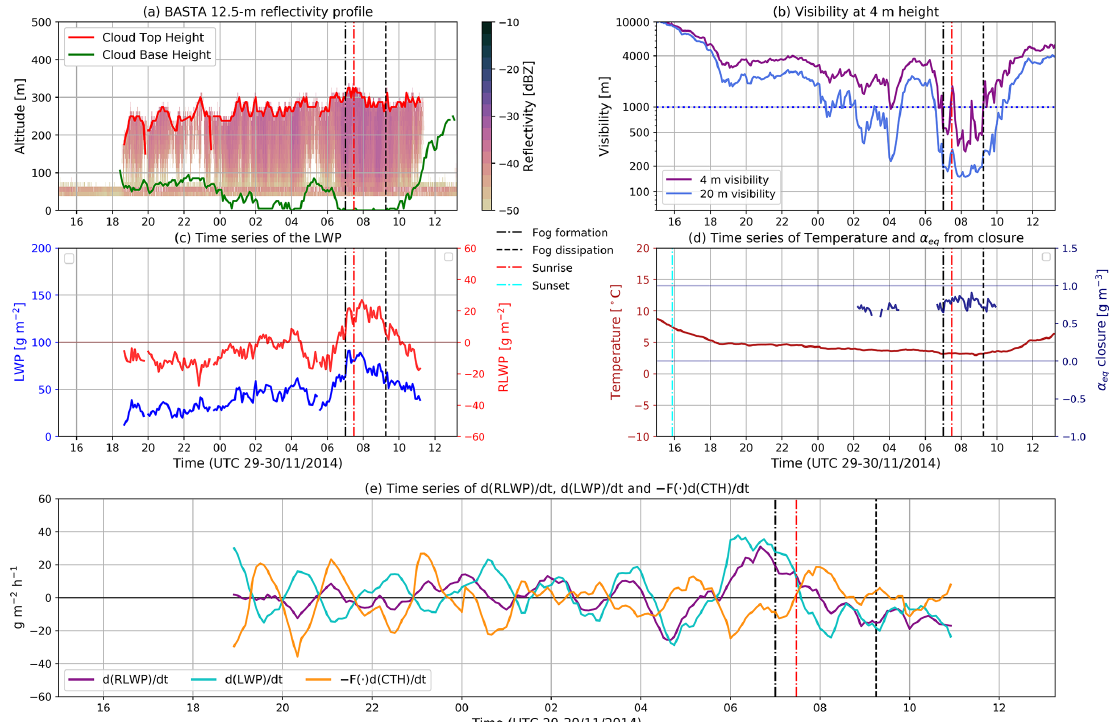
Figure 9. Case study 3. (a) Cloud base height (CBH), cloud top height (CTH), and the cloud radar 12.5m resolution reflectivity profile for the first 1000m of height. (b) Horizontal visibilities at 4 and 20m. (c) Fog–stratus layer measured LWP and computed RLWP. (d) Temperature and closure adiabaticity (calculated only when visibility is less than 2000m). (e) Change rate of RLWP, with the individual contributions from LWP and CTH variations. In each panel, the time of fog formation and fog dissipation are clearly marked as is the time of